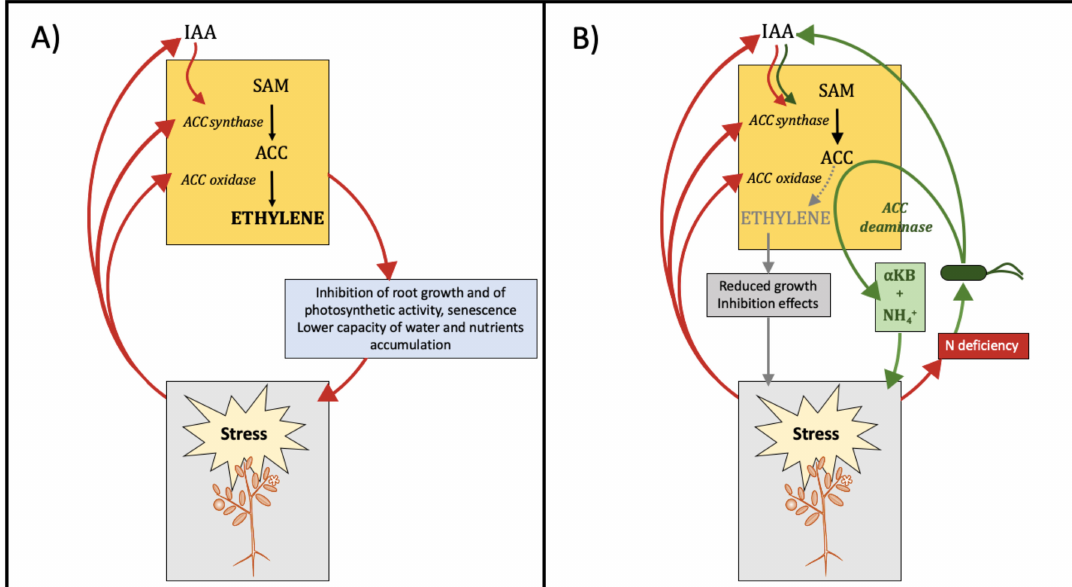
Figure 2. E ff ect of 1-aminocyclopropane-1-carboxylic acid (ACC) deaminase-producing bacteria on ethylene metabolism of stressed plants. ( A ) Biotic and abiotic stresses stimulate the production of ethylene and indole-3-acetic acid (IAA) by the plant. Through the enzyme ACC synthase, S-adenosyl methionine (SAM) is converted into 1-aminocyclopropane-1-carboxylate (ACC). ACC synthase converts ACC into ethylene, which causes a general growth inhibition. IAA induces the expression of ACC synthase and contributes to the stimulation of ethylene production. ( B ) Following the colonization of the plant by ACC deaminase-producing bacteria, ACC is shunted from ethylene to ammonium (NH 4 + ) and α -ketobutyrate ( α KB) production. In addition, nutrient stress (including N shortage) stimulates the production of IAA in bacteria. As a result, plant growth promotion is achieved by increased IAA and reduced ethylene